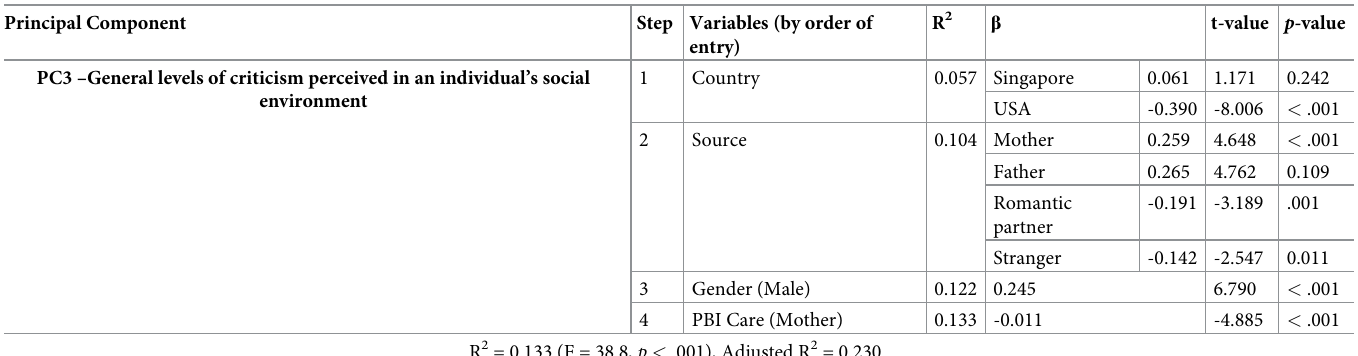
Table 5. Table of final model in stepwise regression for